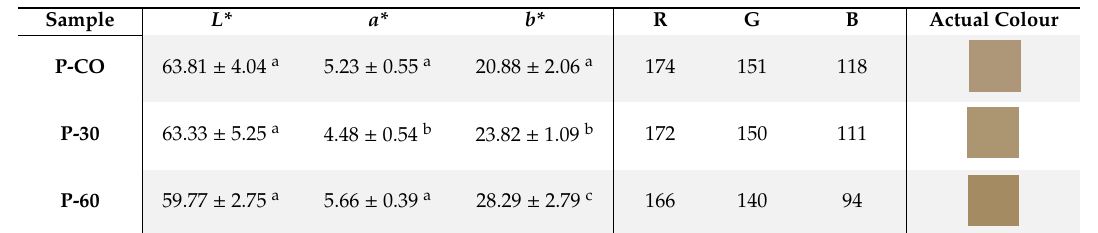
Table 3. Colour parameters (L*, a*, b*) with RGB conversion of p â t é samples (P-CO: control sample; P-30 and P-60: samples with 30% and 60% of pork fat replacement, respectively).